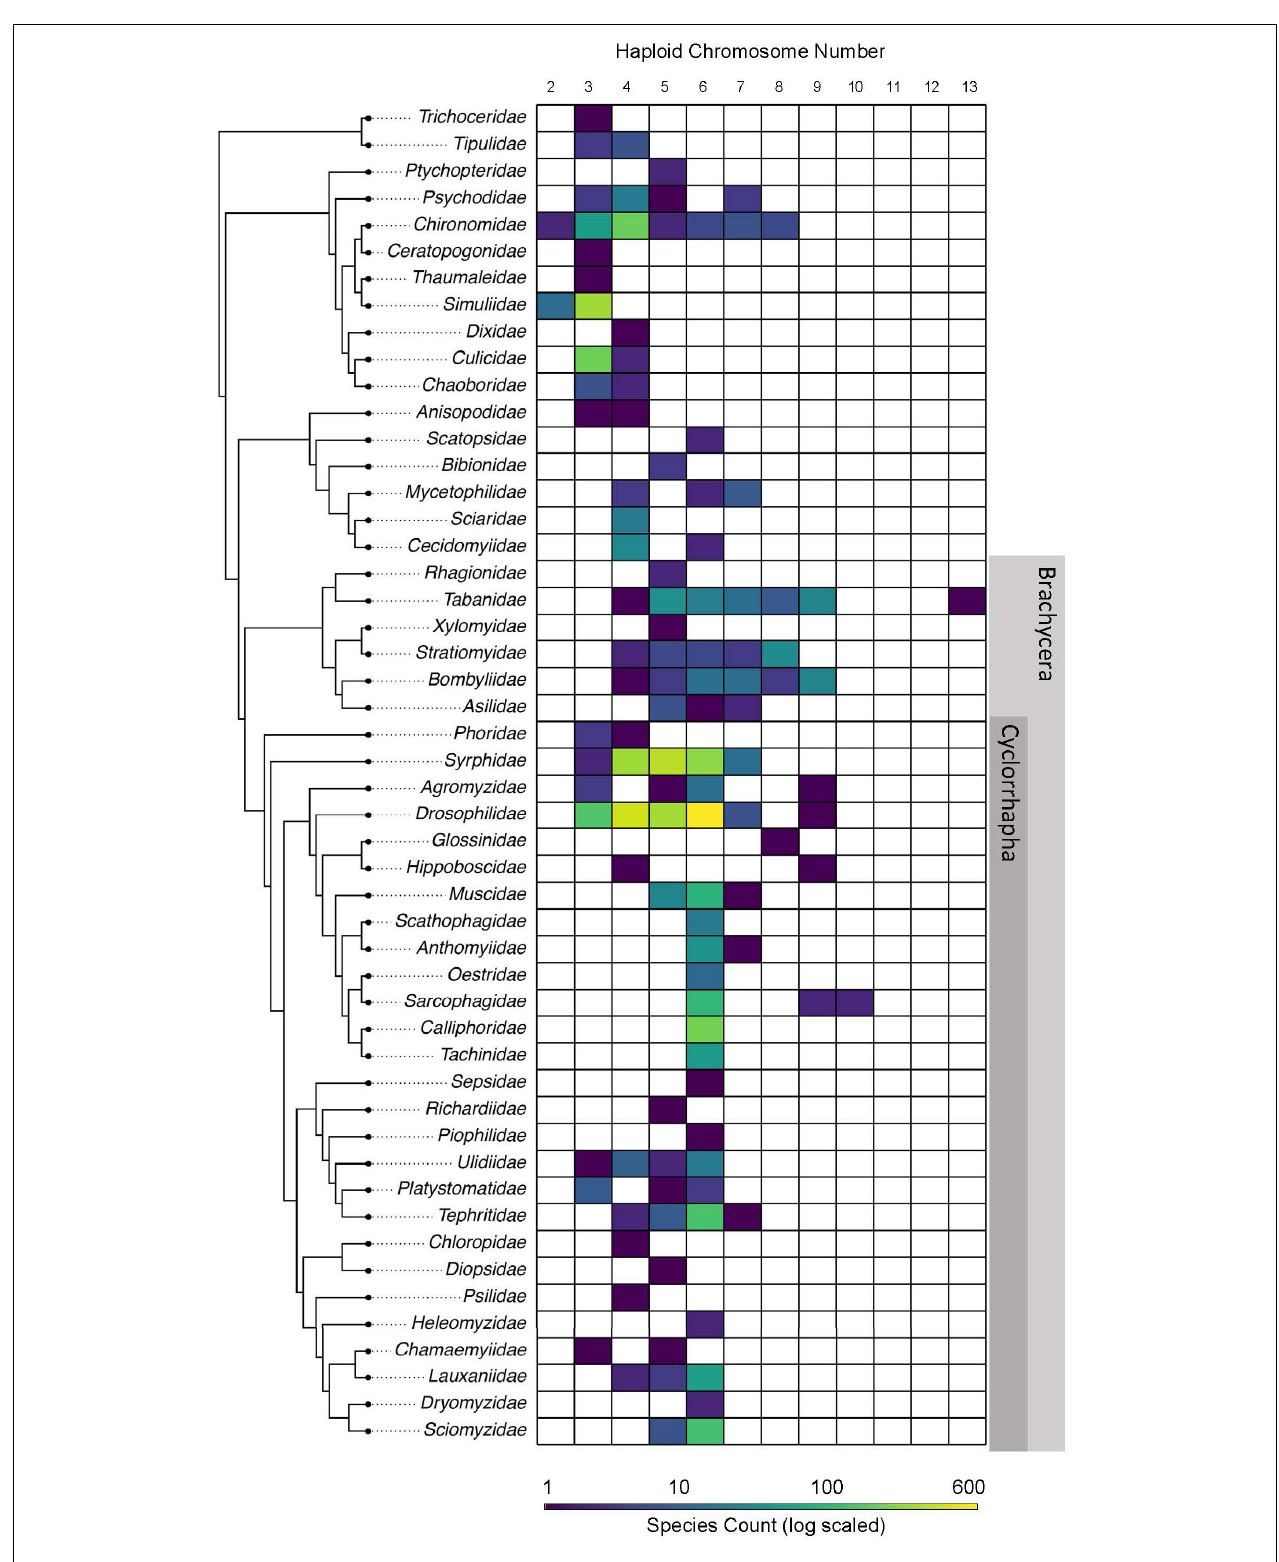
FIGURE 1 | Phylogenetic distribution of haploid chromosome count in Diptera. In each row the number of species with a specific haploid chromosome count is indicated by color. Note the color ramp is on a log scale to allow simultaneous visualization of families like Drosophilidae and Piophilidae which have orders of magnitude differences in the number of records